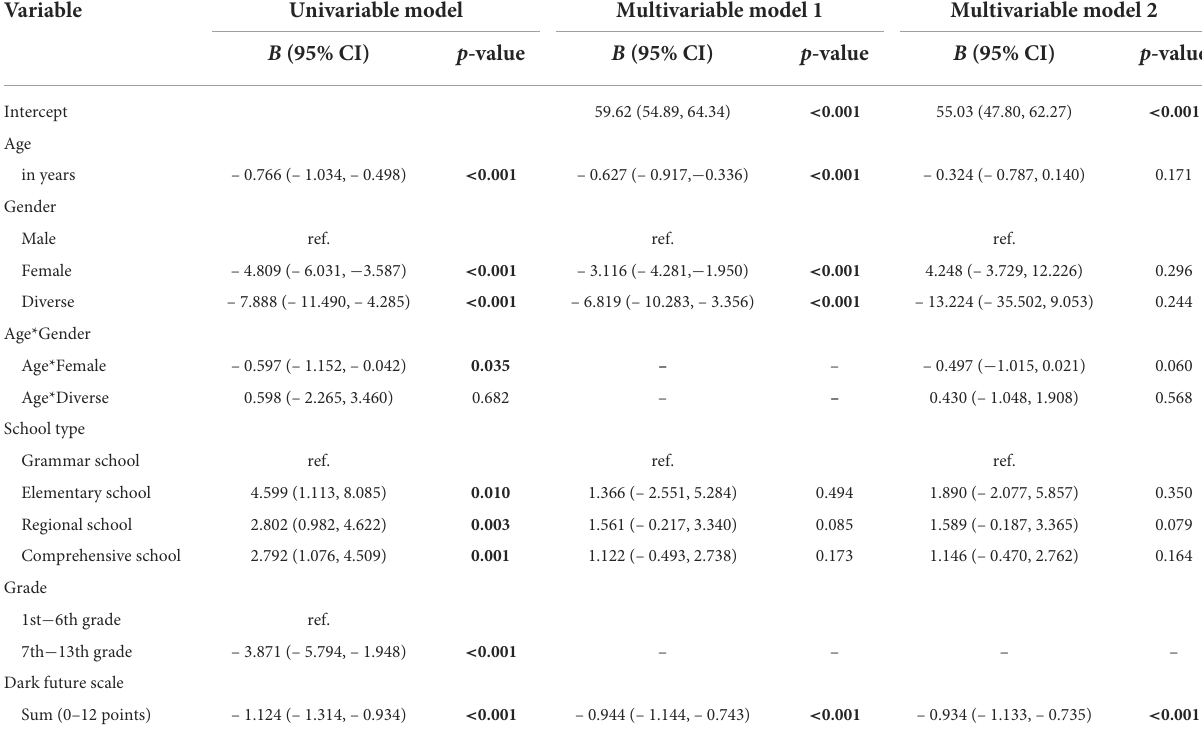
TABLE 4 General linear regression models with health-related quality of life (self-reported KIDSCREEN-10) as dependent variable, N = 787.